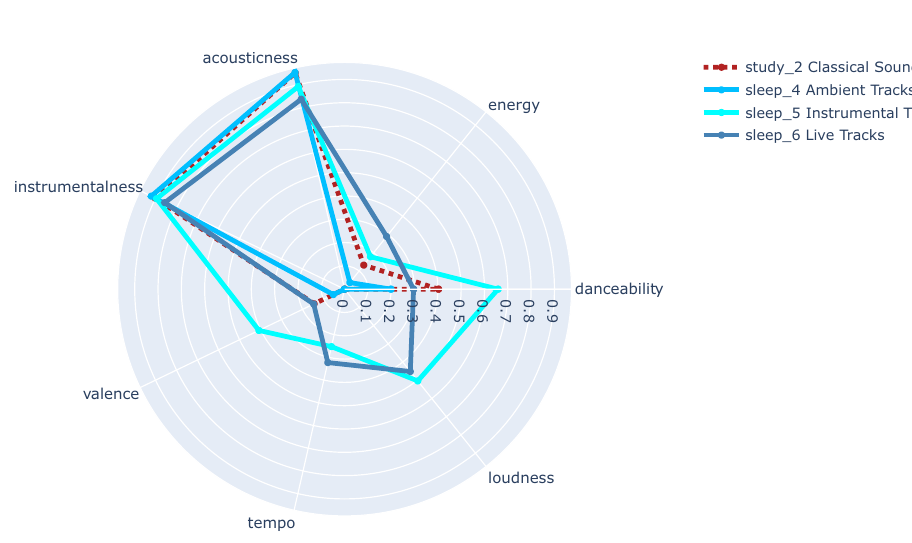
Figure 2. Radar plot of 7 audio features of Study cluster 2 (‘Classical Soundtrack Track’s) and Sleep clusters 4 (‘Ambient Tracks’), 5 (‘Instrumental Tracks’) and 6 (‘Live